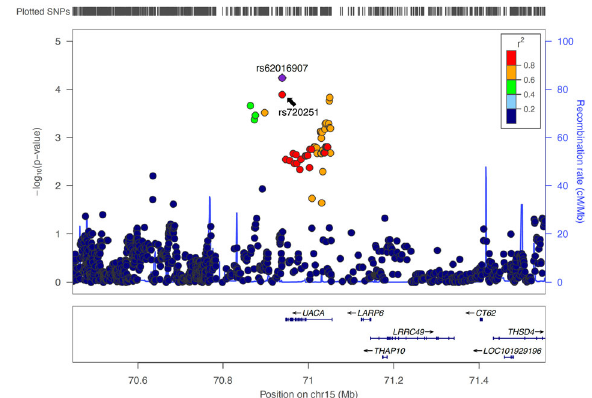
Fig. 6 Locuszoom plot for the association between OS and the UACA locus within the SBCSS and SBCS patients taking anthra- cyclines. All evaluated variants are within 500 kb of the UACA gene. LD structure was based on 1000 genomes ASN population (Nov